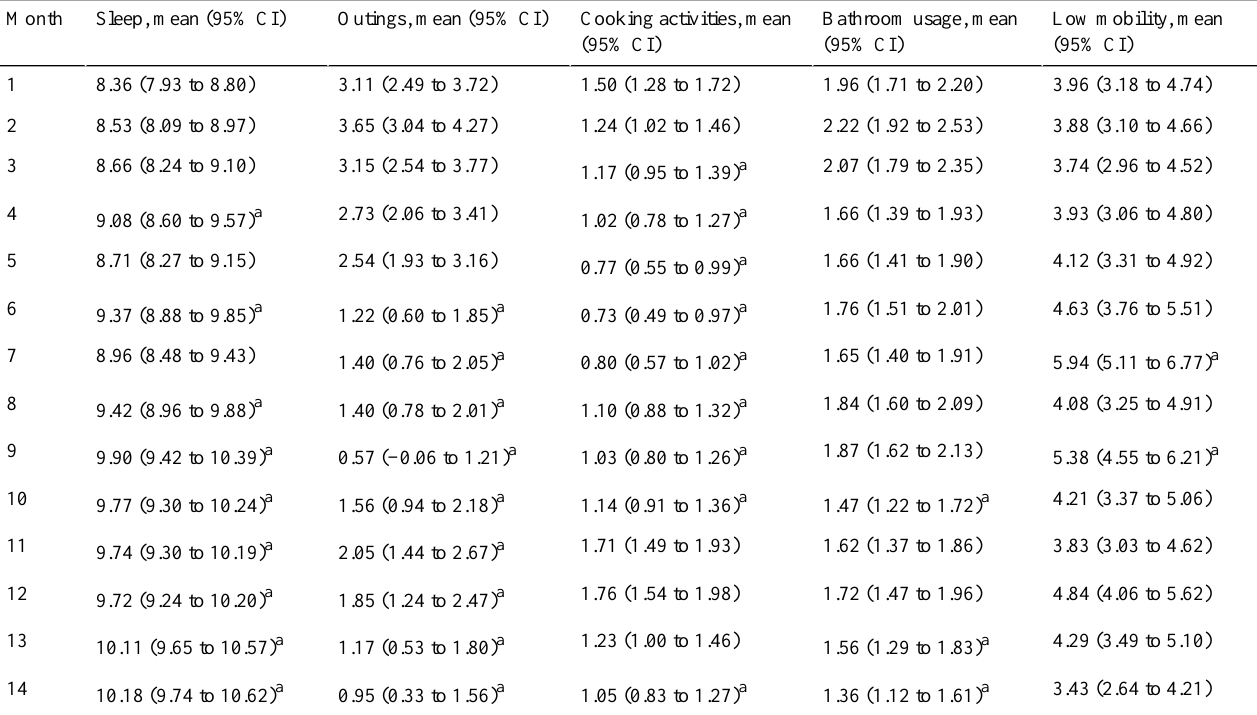
Table 1. Means and 95% CI of repeated measurements for sleeping outings, cooking activities, hygiene, and low mobility during the monitoring